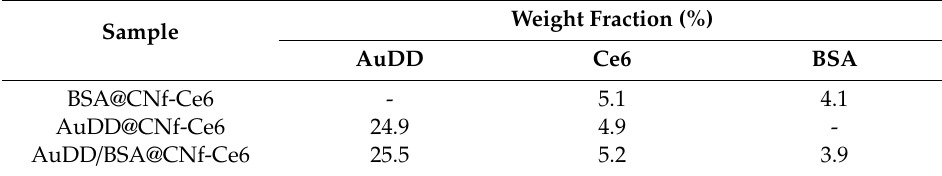
Table 1. Weight fractions of each component in the CNf-Ce6-based nanofibers. Sample